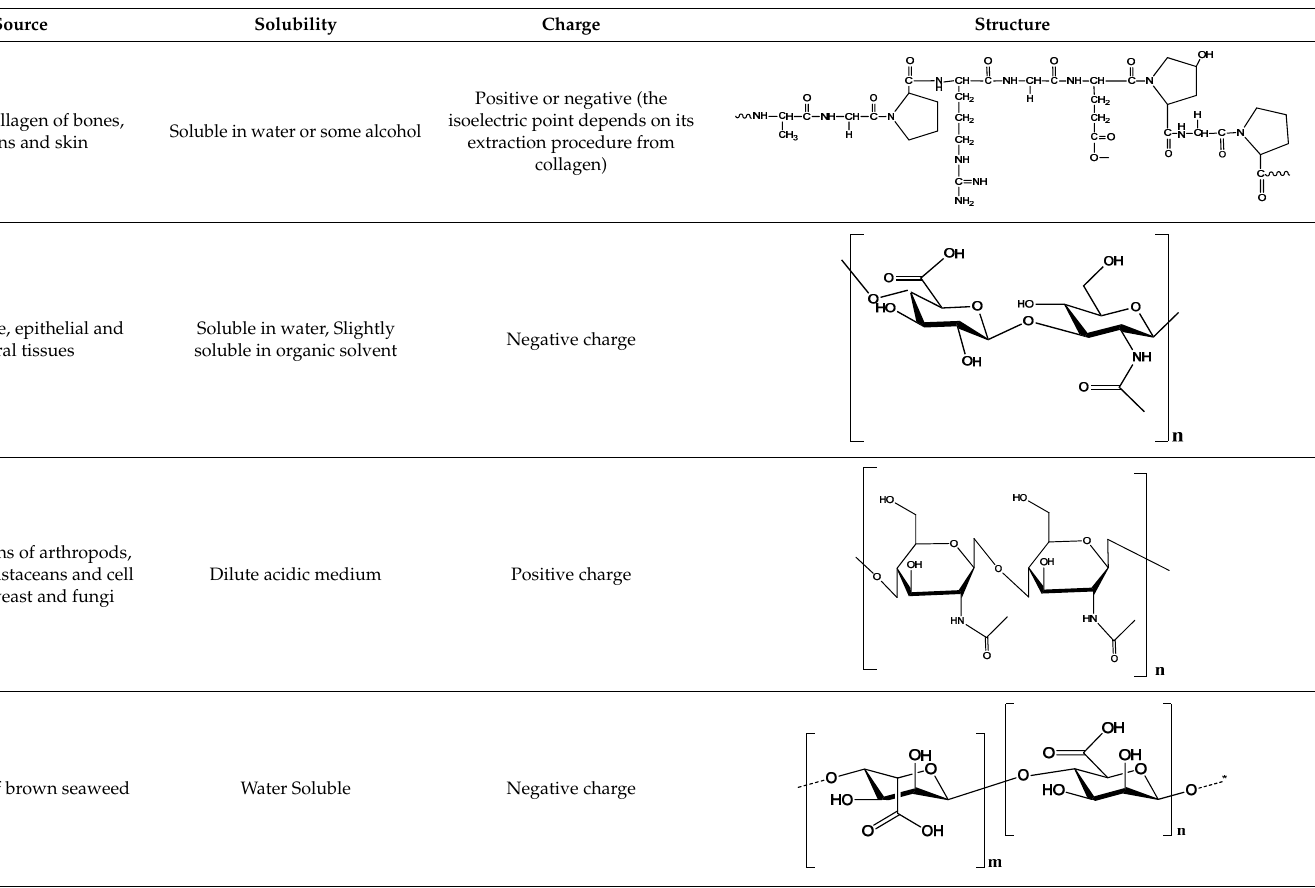
Table 1. Origin, chemical structure and properties of polymers.